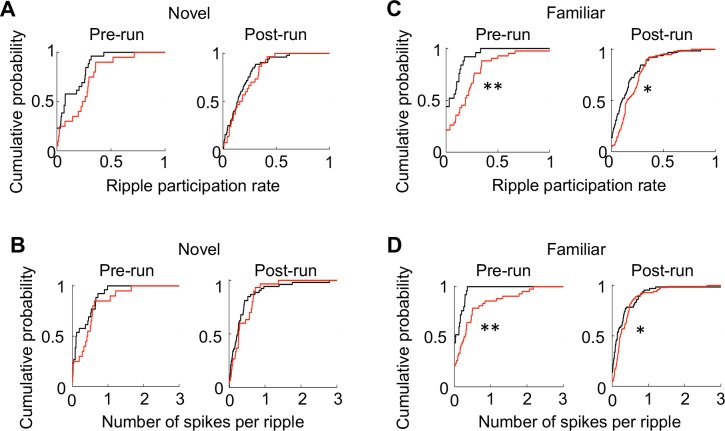
Run-active cells in RTT mice displayed enhanced activities within ripples.(A) Cumulative distributions of ripple participation rate for run-active cells in WT and RTT mice before (Pre-run) and after (Post-run) running on the novel track. Pre-run: p=0.07, Wilcoxon ranksum test; N = 26 (WT), 20 (RTT). Post-run: p=0.39, N = 53 (WT), 31 (RTT). (B) Same as (A), but for number of spikes per ripple event. Pre-run: p=0.23; N = 26 (WT), 20 (RTT). Post-run: p=0.22, N = 53 (WT), 31 (RTT). (C) Cumulative distributions of ripple participation rate for run-active cells in WT and RTT mice before (Pre-run) and after (Post-run) running on the familiar track. Pre-run: **p=0.0023, Wilcoxon ranksum test; N = 24 (WT), 42 (RTT). Post-run: *p=0.012, N = 65 (WT), 103 (RTT). (D) Same as (C), but for number of spikes per ripple event. Pre-run: **p=0.0025; N = 26 (WT), 20 (RTT). Post-run: *p=0.019, N = 53 (WT), 31 (RTT).